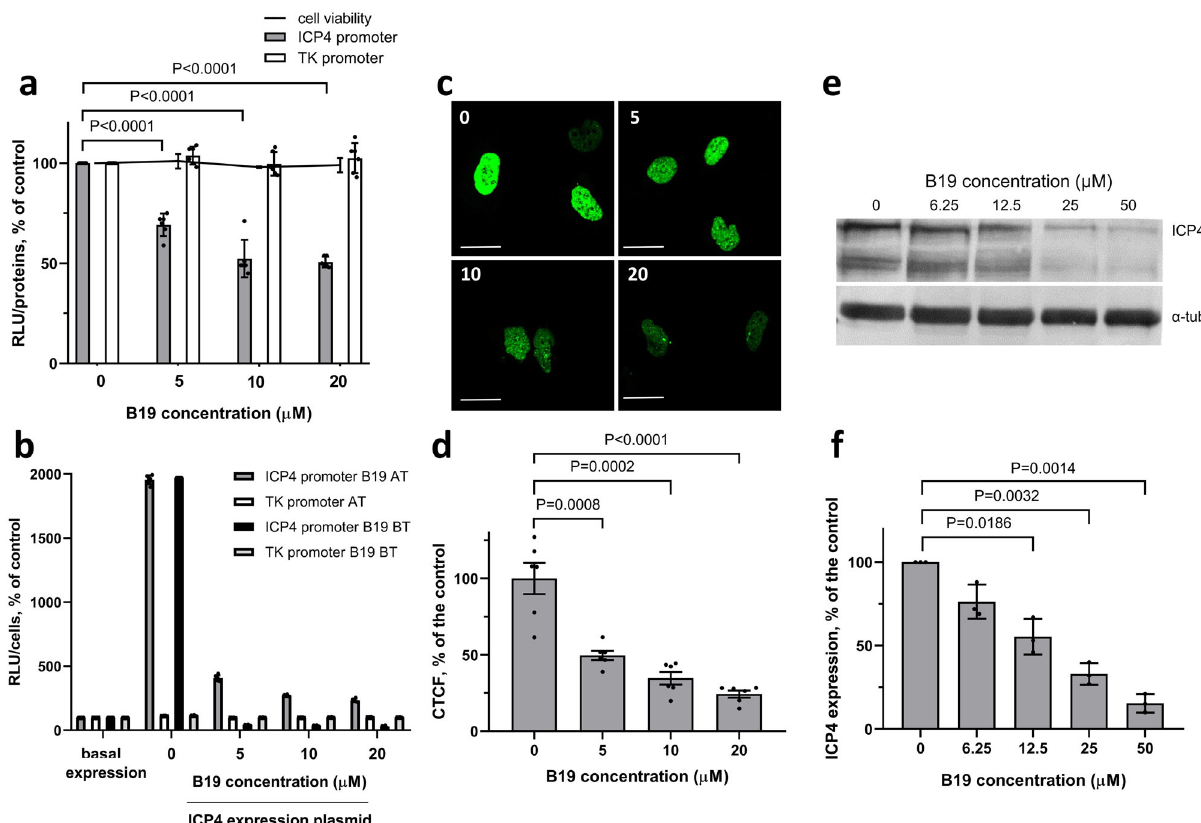
Fig. 5 ICP4 expression in the presence of the G4-ligand B19. a Luciferase reporter assay of ICP4 promoter and control TK promoter activity in the presence of increasing B19 concentrations. ICP4 and TK promoters were cloned in the promoterless pGL-4.10 plasmid upstream of the luciferase gene and transfected into U-2 OS cells. U-2 OS cell viability in the presence of increasing concentrations of B19 was also evaluated. Two independent experiments